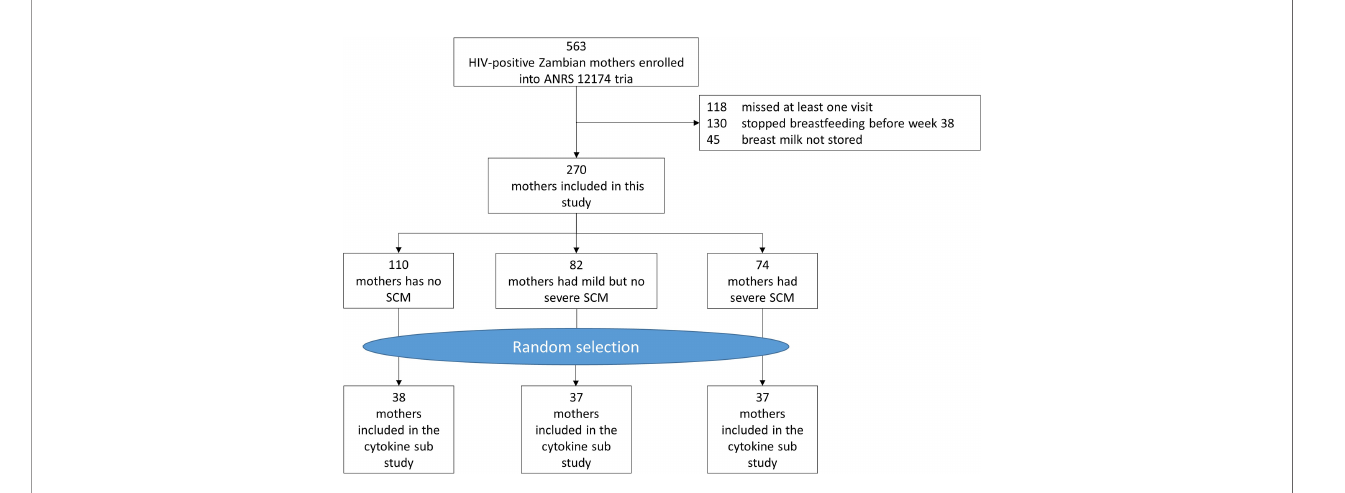
FIGURE 1 | Participants fl ow